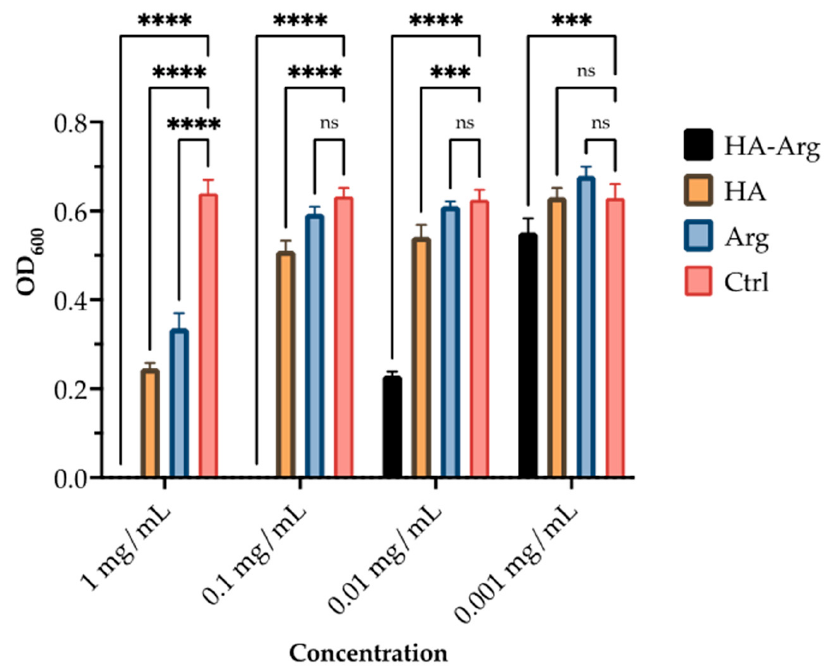
Figure 10. Antimicrobial activity of HA, Arg, and HA–Arg against S. pneumoniae . Bacterial growth was quantified by OD 600 using a spectrophotometer. Data are the mean of 3 independent experiments performed in triplicate (mean +/ − SD);ns p ≥ 0.1; *p < 0.1; **p < 0.01; ***p < 0.001; ****p ≤ 0.0001 (TWO WAY ANOVA followed by Dunnett post test).